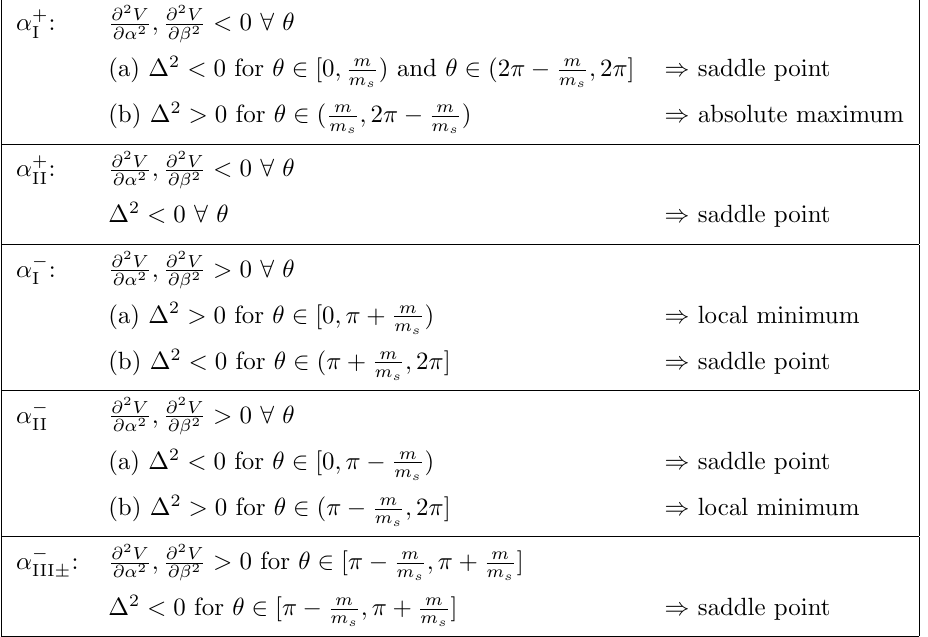
Table 1 . Classi(cid:12)cation of the stationary points of V ( (cid:11); (cid:12); (cid:18)